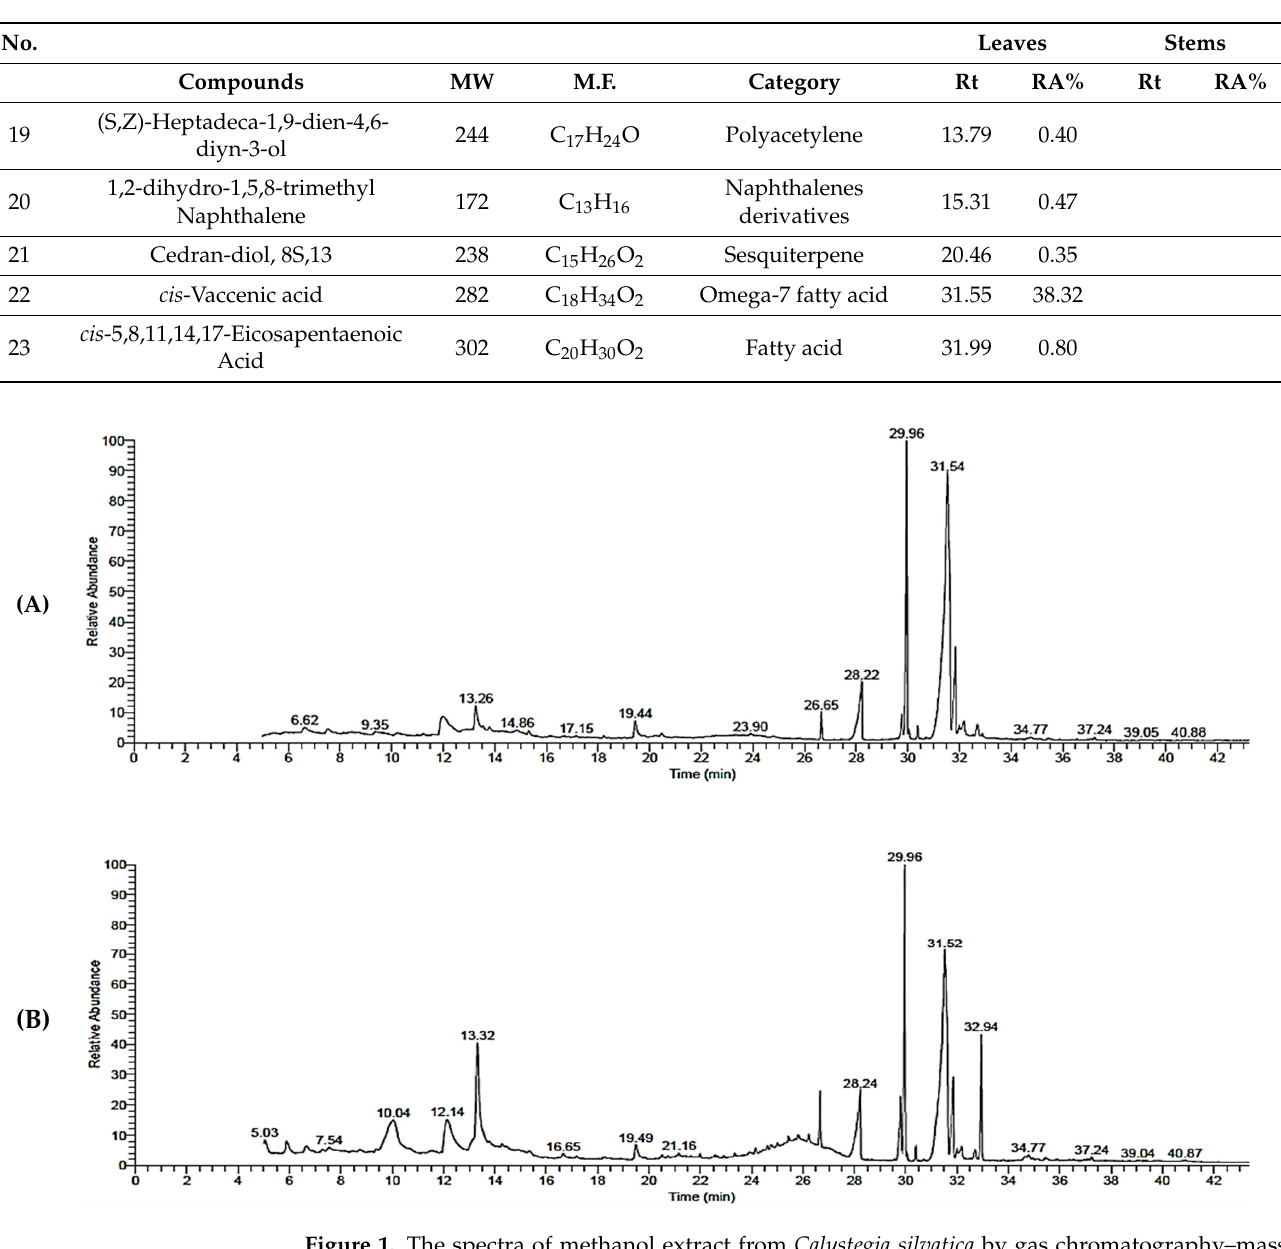
Figure 1. The spectra of methanol extract from Calystegia silvatica by gas chromatography–mass spectrometry: ( A ) leaves extract; ( B ) stems extract. Table 2. Biological compound identification of n -hexane extract from Calystegia silvatica leaves